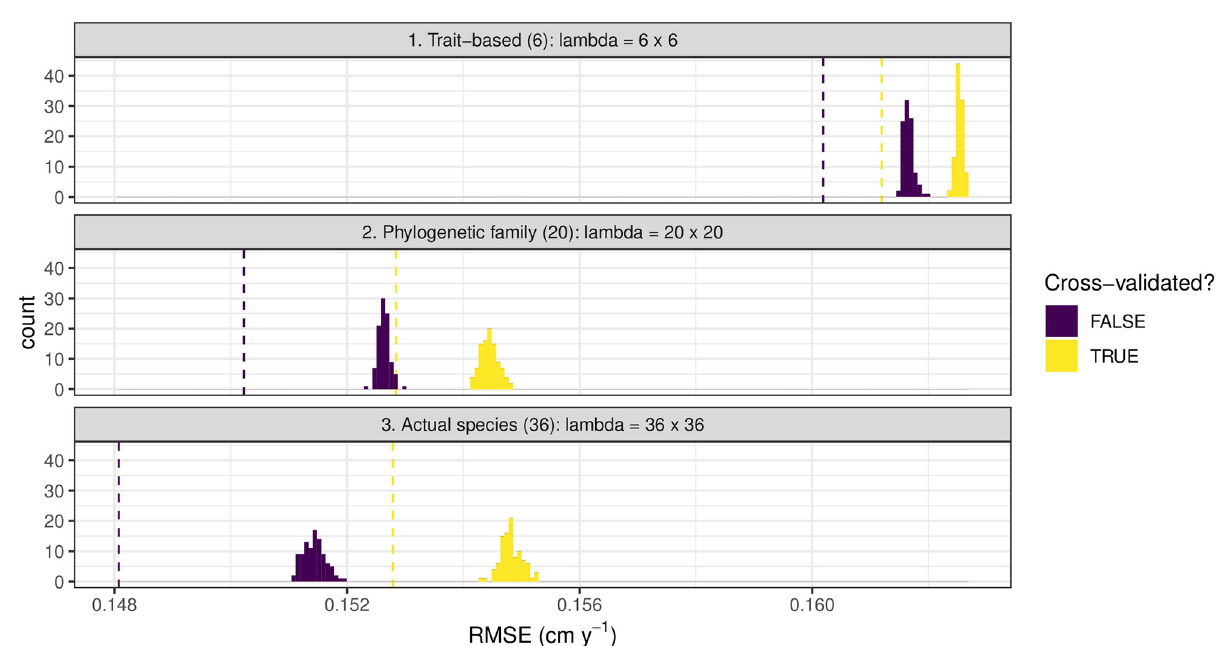
Fig 2. Comparison of the RMSE for all three species-groupings models. We calculated the RMSE with and without spatial cross-validation. The dotted lines indicate the RMSE value when the competitor species’ identities were not permuted. The histograms indicate the distribution of the RMSE values resulting from 99 permutations of competitor species’